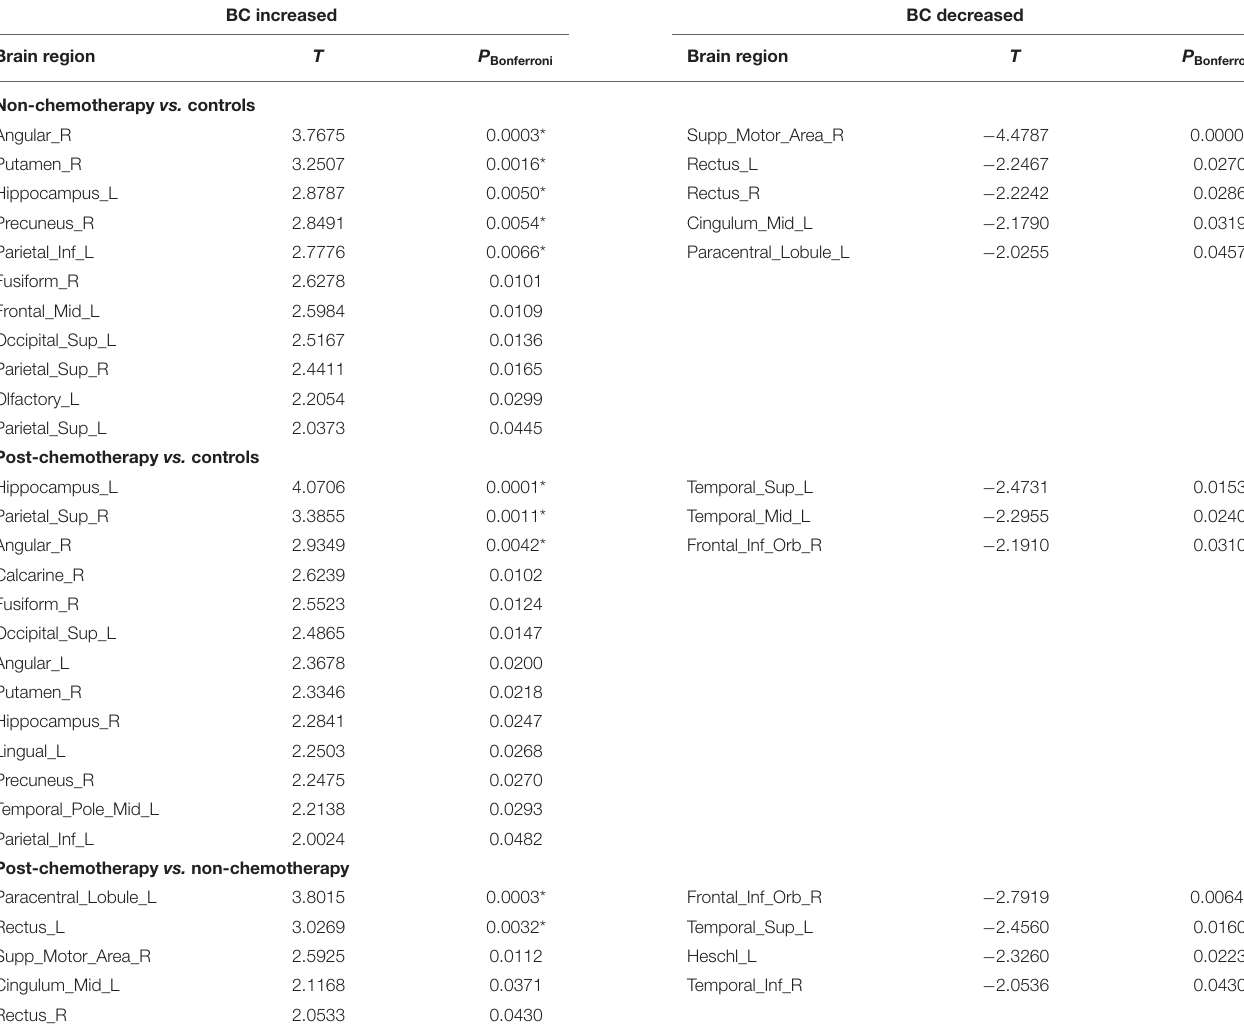
BC increased BC decreased Brain region P